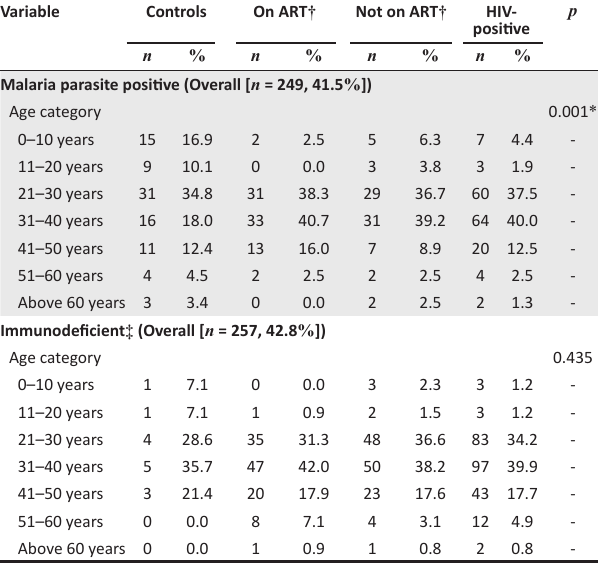
TABLE 4: Comparison of malaria and immunodeficiency with age of HIV-positive and HIV-negative individuals in Abuja, Nigeria 2012–2013. Variable Controls